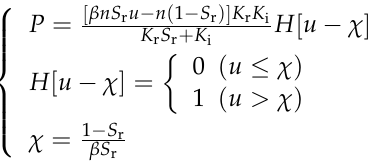
Figure 11. DIF versus impact velocity and saturation of the sample.